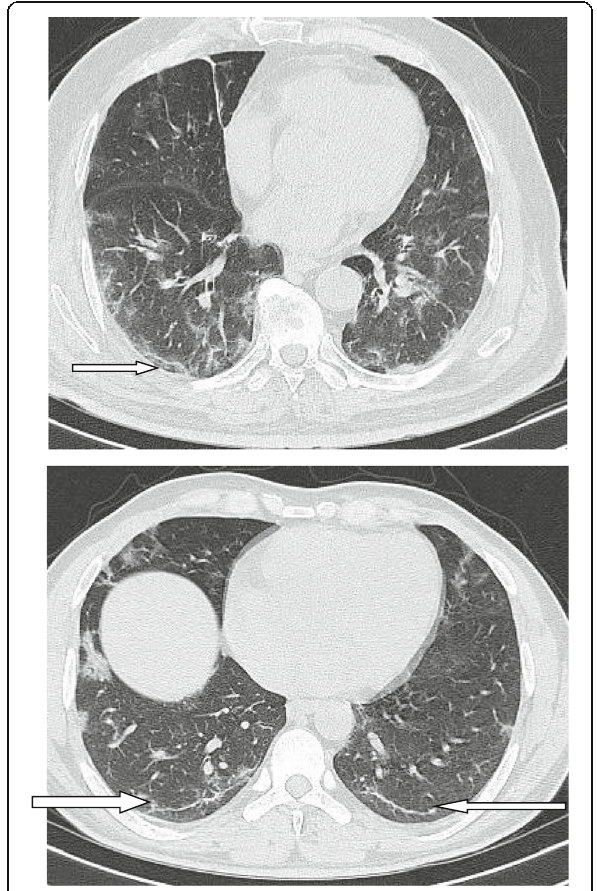
Fig. 13 Two different patients with COVID-19 pneumonia with subpleural lines (arrow), note also the presence of patches of ground glass infiltration